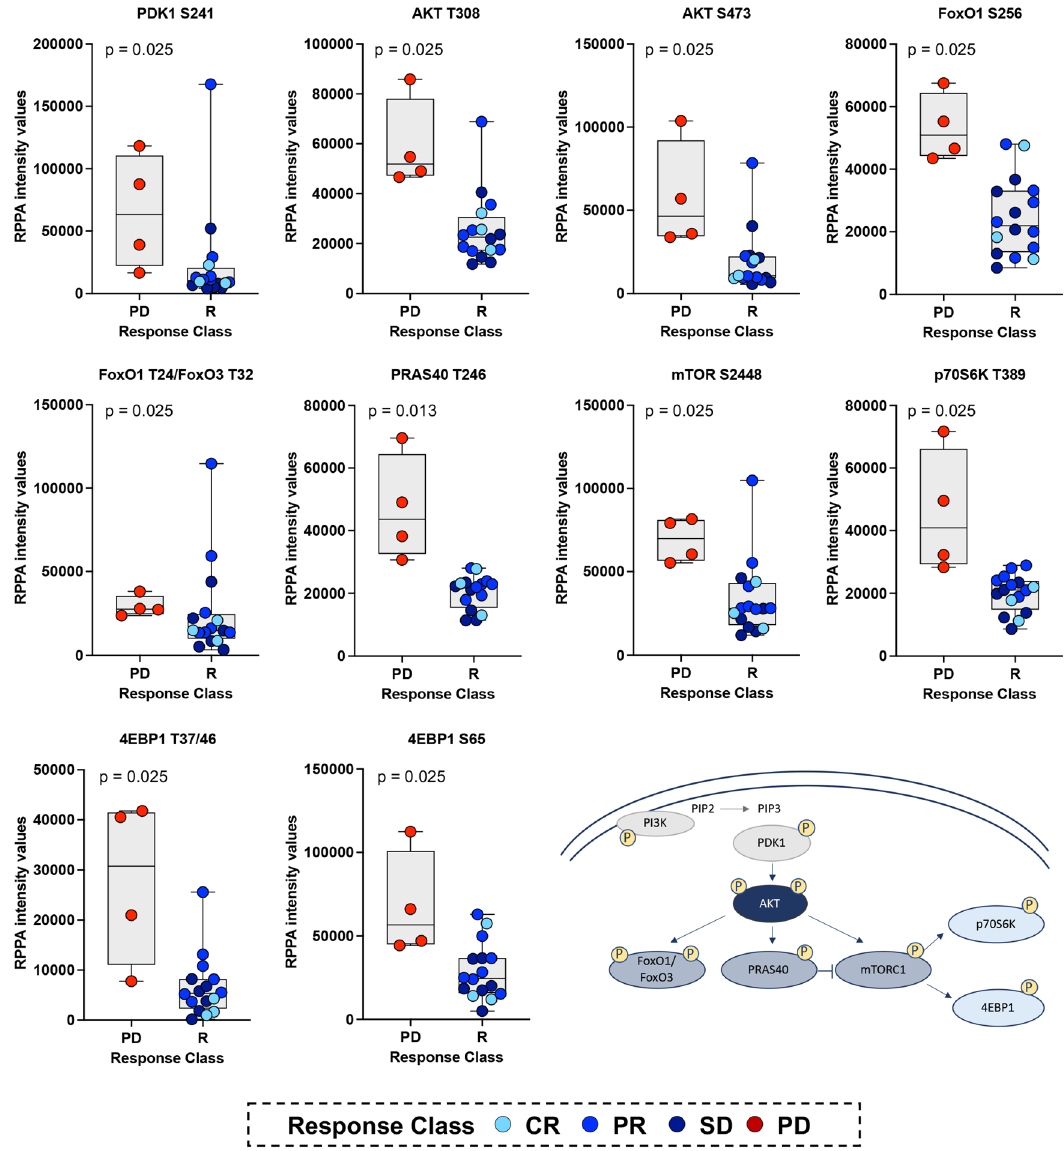
Fig. 3 Global activation of the PI3K/AKT/mTOR signaling pathway in patients with progressive disease compared to responders. Box plots with median (center line) and maximum and minimum values (whiskers) show a statistically signi fi cant increase in the activation levels of many members of the PI3K/AKT/mTOR signaling pathway in the tumor epithelium of patients with progressive disease compared to responders; p values for two-sided chi-square tests for dichotomized levels of measured biomarkers (above/below the population median) are